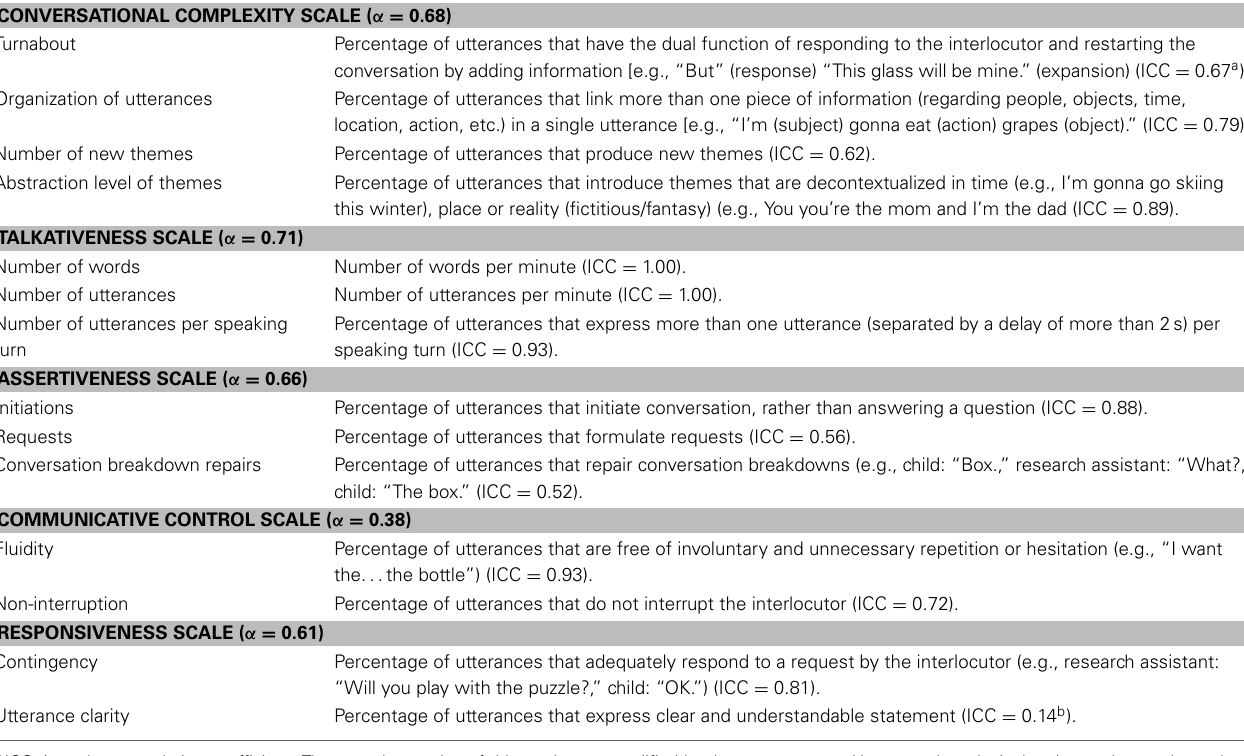
Table 1 | Description of the pragmatic skills coding system—preschool version. CONVERSATIONAL COMPLEXITY SCALE ( α =